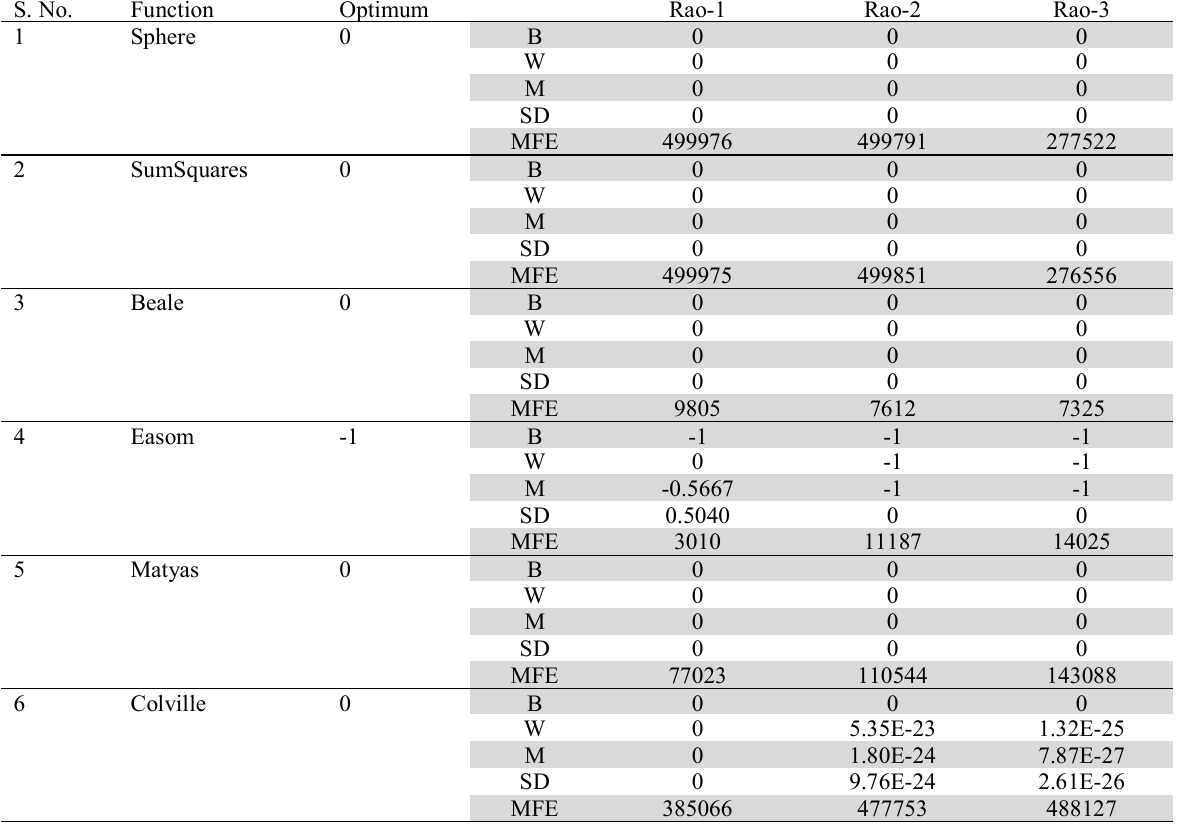
Results of the proposed algorithms for the unconstrained benchmark functions S. No. Function Optimum Rao-1 Rao-2